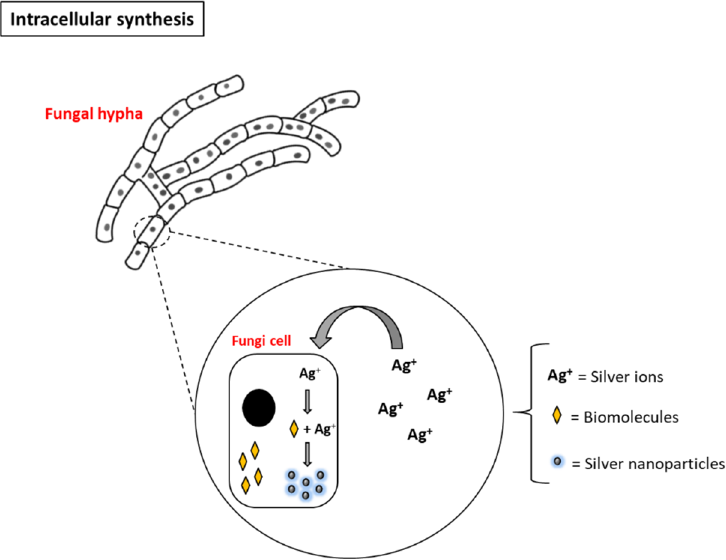
Figure 2. Intracellular biosynthesis of silver nanoparticles mediated by fungi. Extracellular synthesis can involve either microbial biomass in direct contact with silver or extracts from microorganisms. Extracellular synthesis mediated by microbial biomass occurs through the interaction of silver ions with proteins present on the external surface of microorganisms’ cell wall, due to negative charges on the cell wall surface due to the presence of carboxylic groups or amine groups (Figure 3). The resulting nanoparticles adhere to the surface of the microorganisms, which makes it necessary to use separation techniques to isolate the nanoparticles, similar to what observed in intracellular synthesis, a factor that can generate more costs during material processing